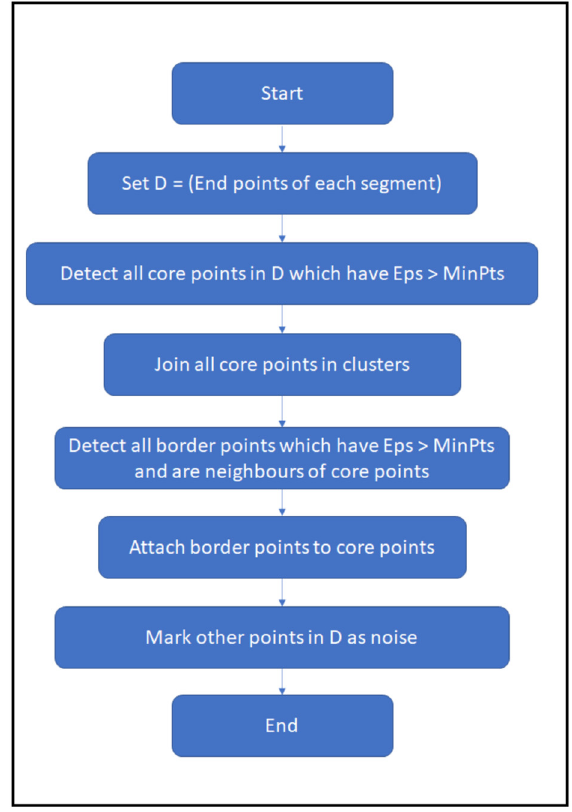
Figure 3. DBSCAN-based LiDAR object detection.